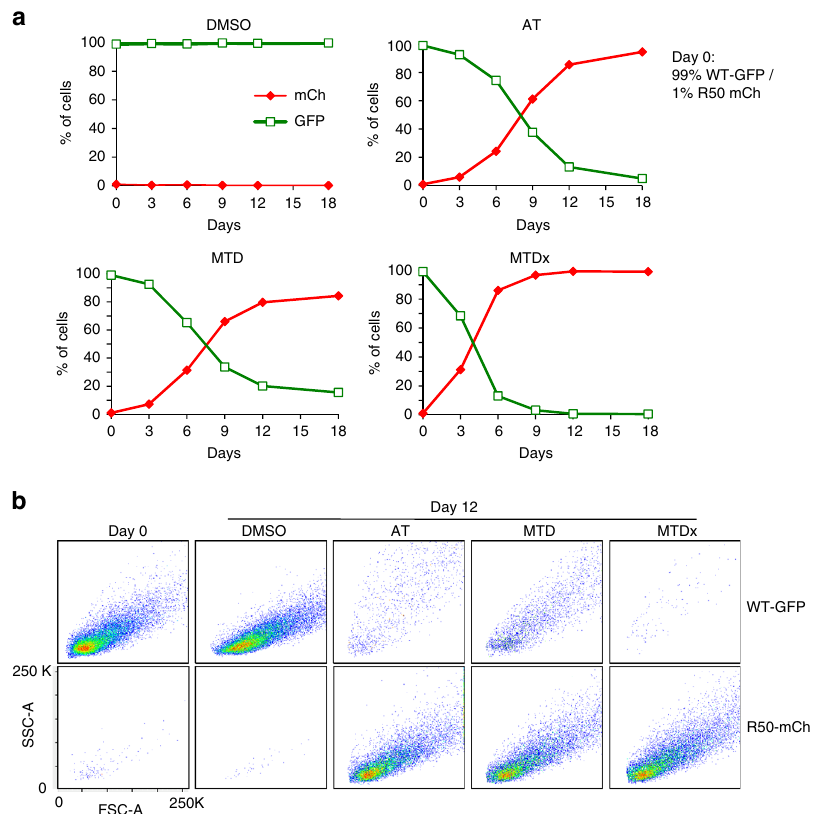
Fig. 4 AT does not outperform MTD in limiting tumour growth in a monolayer culture. a Sensitive GFP+ and R50 mCherry+ cells were plated in monolayer at initial 99:1 ratio, in the presence of either DMSO as control or NU6102: AT condition (15 μ M initial drug concentration, ± 20% at 3-day intervals to maintain stable 70 – 80% con fl uence), MTD (50 μ M for 24 h, with 48 h no drug) or MTDx (continuous 50 μ M). Every 3 days, the proportion of GFP+ and mCh+ cells was determined by fl ow cytometry. b Flow cytometry analysis (forward scatter area, FSC-A, which increases with cell size, and side scatter area, SSC-A) of cell size of WT-GFP+ and R50-mCh+ cells from the experiment in a , at day 0 and day